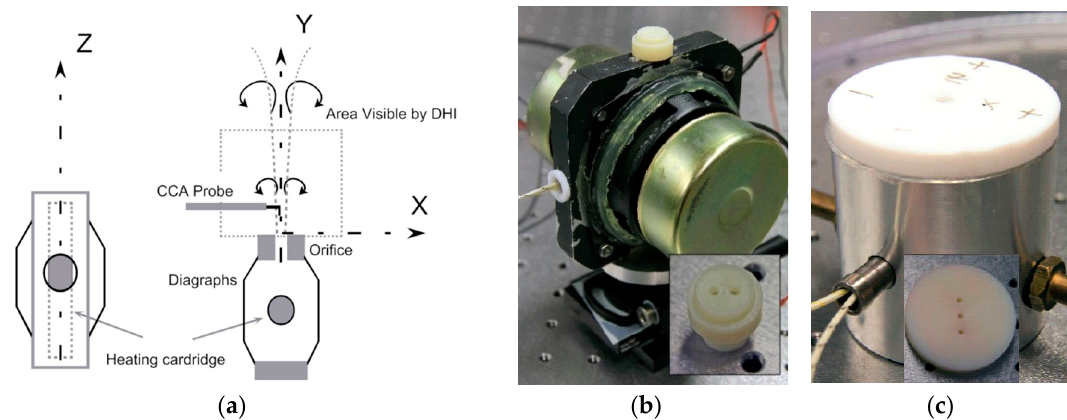
Figure 3. Experimental arrangement of the SJ actuators for DHI measurement: ( a ) Schematic view of the actuator, which consists of a heating cartridge, a pair of loudspeakers, and an orifice (the loudspeakers are not mentioned, and are shown in picture 3( a )) [67], ( b ) the pair of loudspeakers, and the detailed view of the two output orifices for the second actuator, ( c ) a detailed view of the steady (continual) nozzle with three output orifices.